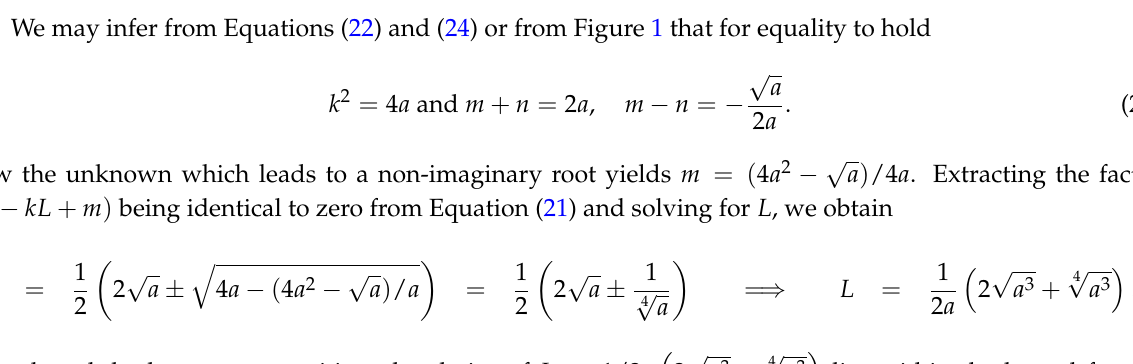
Figure 1. Nested fixed point and approximating